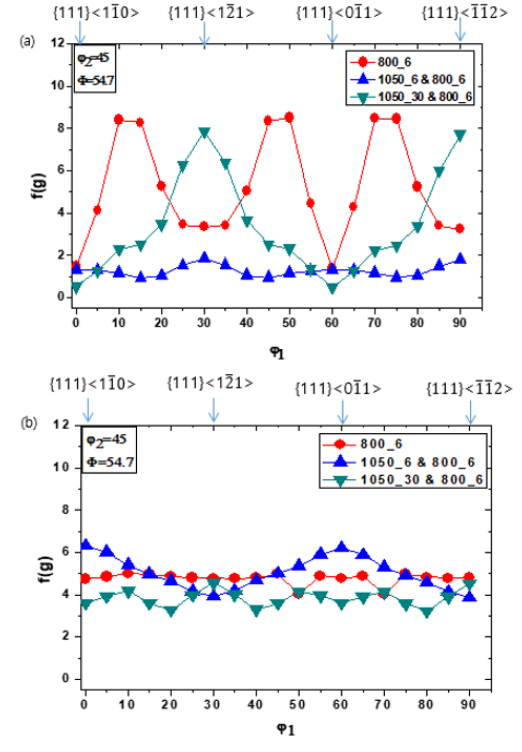
Figure 10. Evolution of the ODF intensity f (g) in the γ - fiber (Φ = 54.7° and φ 2 = 45°, constant) components of the steels subjected to different intermediate heat treatment conditions: ( a ) alloy B and ( b ) Gr.92.